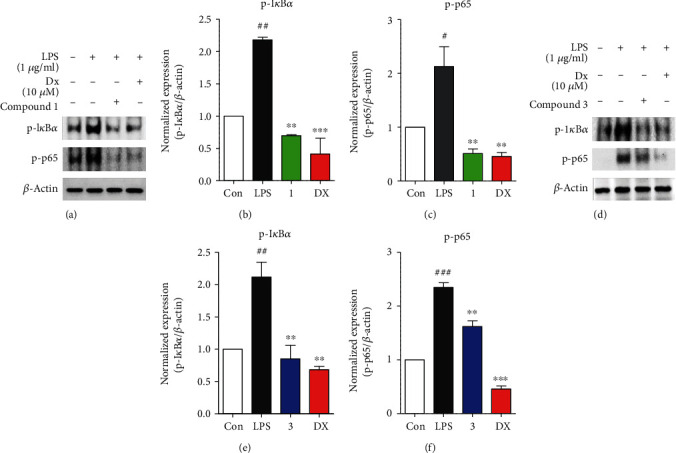
Compounds 1 and 3 attenuated the NF-κB signaling pathway. (a, d) Immunoblot analysis displayed that activation of the NF-κB signaling pathway was suppressed by compounds 1 (a) and 3 (d) in RAW264.7 cells. (b, c, e, f) The graph was expressed as the values of the relative ratio IκBα or p65 to β-actin protein expression level using densitometry. Cells were pretreated for 2 h with compounds 1 and 3 at concentrations of 5 and 10 μM, respectively, and stimulated with LPS (1 μg/mL) for 1 h. Dexamethasone was used as the positive control, and immunoblots analysis performed triplicate experiments. Values are means ± SEM, and an unpaired Student t-test was used for statistical analysis. #p < 0.05, ##p < 0.01, ###p < 0.001, ∗p < 0.05, ∗∗p < 0.01, and ∗∗∗p < 0.001 represented significant differences from the LPS-treated group.